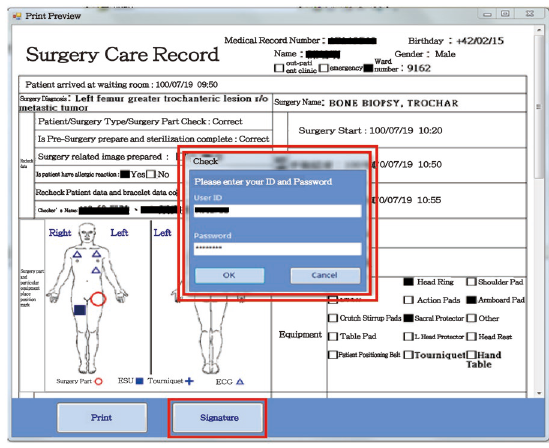
Figure 5. The surgical care records